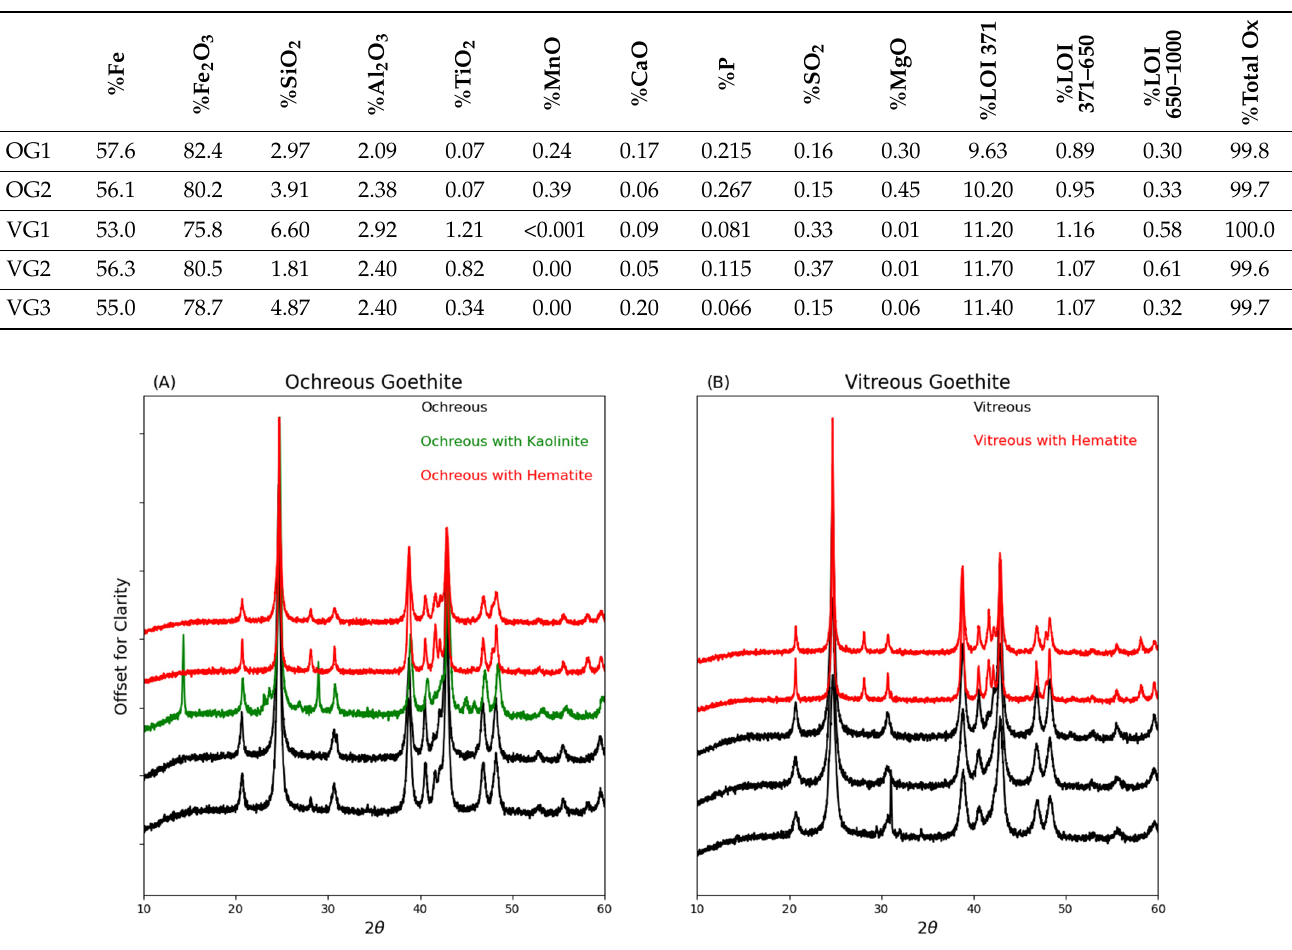
Figure 1. XRD patterns for the 5 ochreous ( A ) and the 5 vitreous goethite samples ( B ) used in the study. Two of the ochreous samples in ( B ) were excluded due to occurrence of hematite, shown in red, and one due to the presence of kaolinite shown in green. Two of the vitreous samples in ( B ) were also excluded due to the presence of hematite (shown in red).